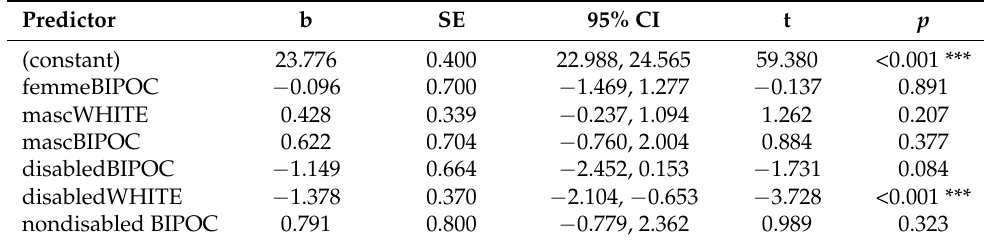
Table 8. Predicting QOL by intersecting identities.